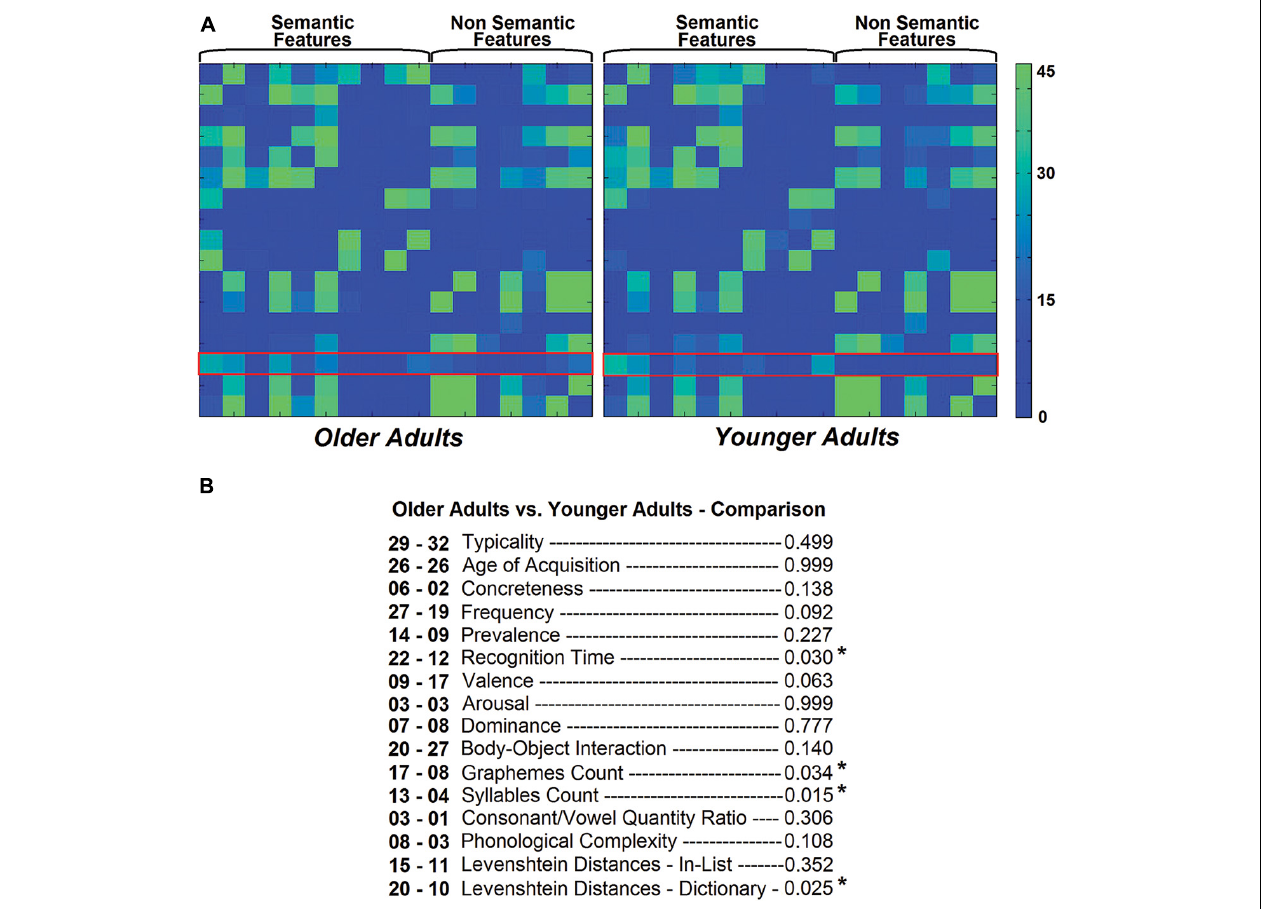
FIGURE 5 | Edge frequency in the two groups. A red frame was added to highlight the edges relevant to this study (A) . A count of all these edges within each group is included below together with the outcome of the chi-square tests comparing edges between the two group frequencies, older and younger adults, respectively (B) . Four pathways showed significant between-group differences. These same pathways approached or showed a trend toward significance when z-transformed correlation coefficients were analysed, as illustrated in Figure 2 . Similarly, the edge toward valence approached significance in these